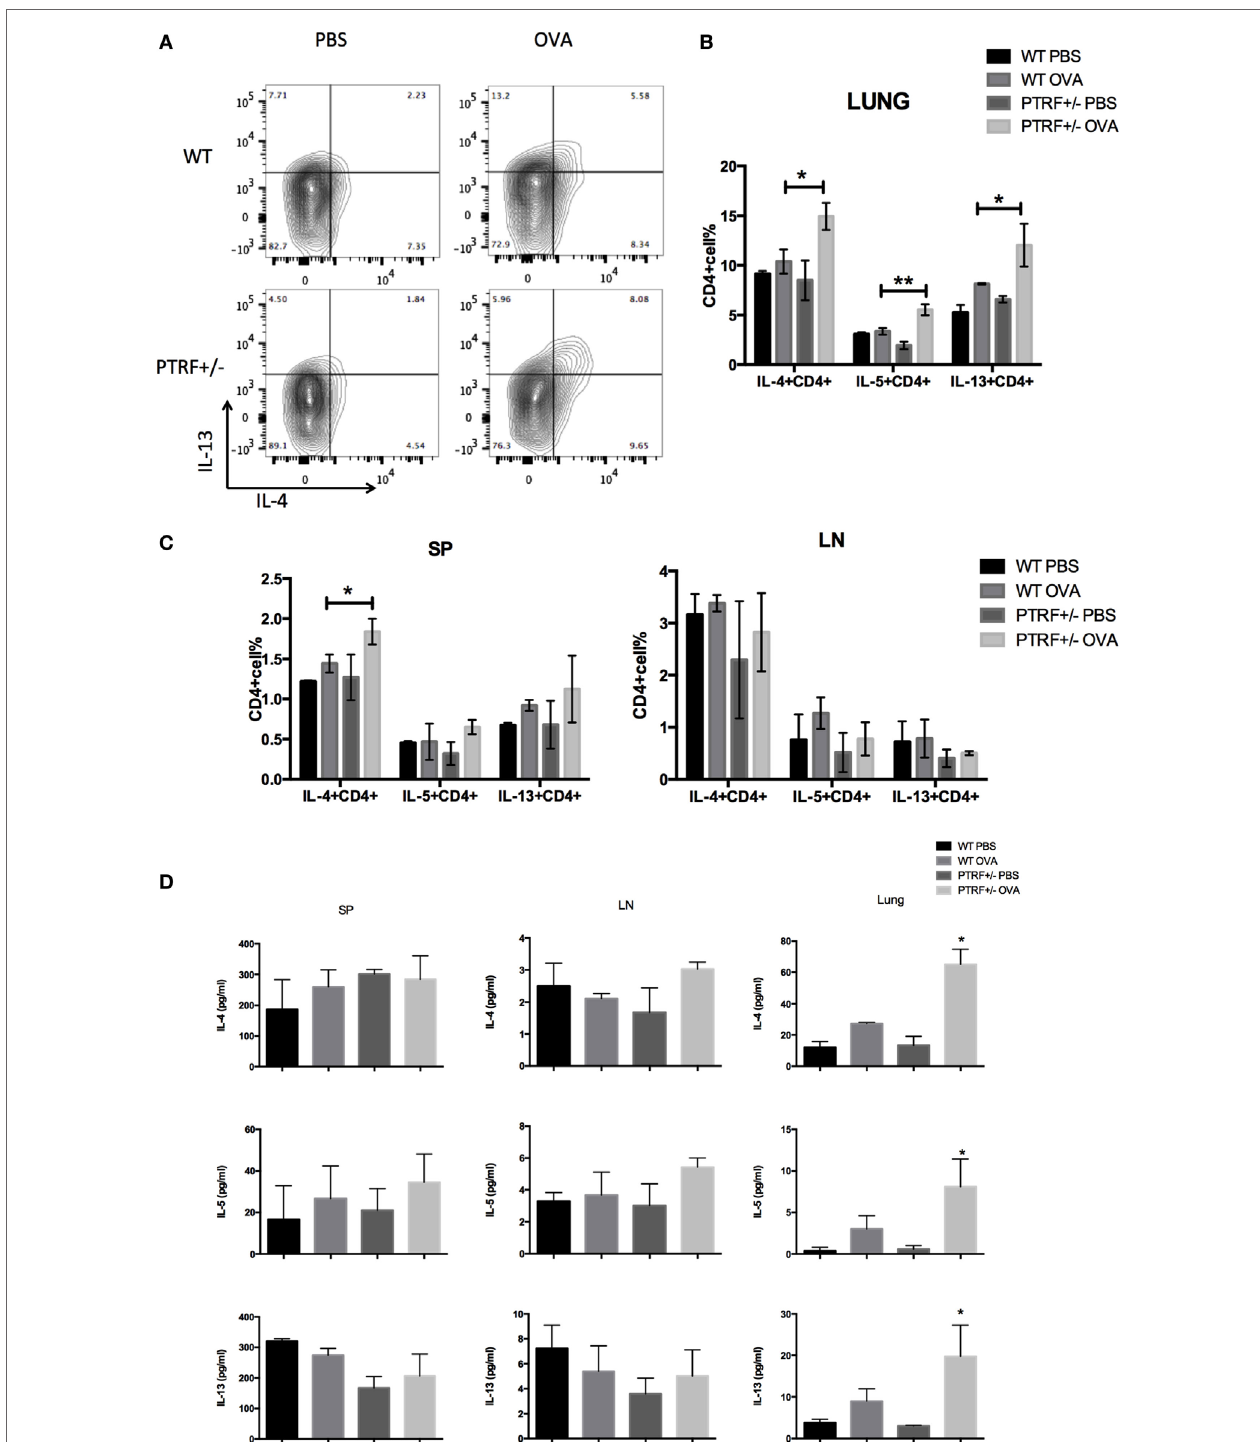
FigUre 2 | Partial loss of polymerase I and transcript release factor (PTRF) led to enhanced local type 2 immune responses. Mice were intraperitoneally injected with PBS or ovalbumin (OVA) on days 0, 7, and 14, and then challenged with PBS or OVA on days 21–27. (a) Representative figure shown the IL-13 + IL- 4 + CD4 + T cells from WT and PTRF + / − littermates. (B) Percentages of IL-4 + , IL-5 + , IL-13 + CD4 + T cells from lung of WT and PTRF + / − littermates. (c) Percentages of IL-4 + , IL-5 + , IL-13 + CD4 + T cells from spleen and peripheral lymph nodes of WT and PTRF + / − littermates. (D) IL-4, IL-5, and IL-13 levels in culture supernatant of lymphocytes from lung, spleen, and peripheral lymph nodes of WT and PTRF + / − littermates. * p < 0.05, ** p < 0.01, as determined by Student’s t -test. Results are pooled data from four independent experiments (mean ± SEM of n = 4 mice in each group).